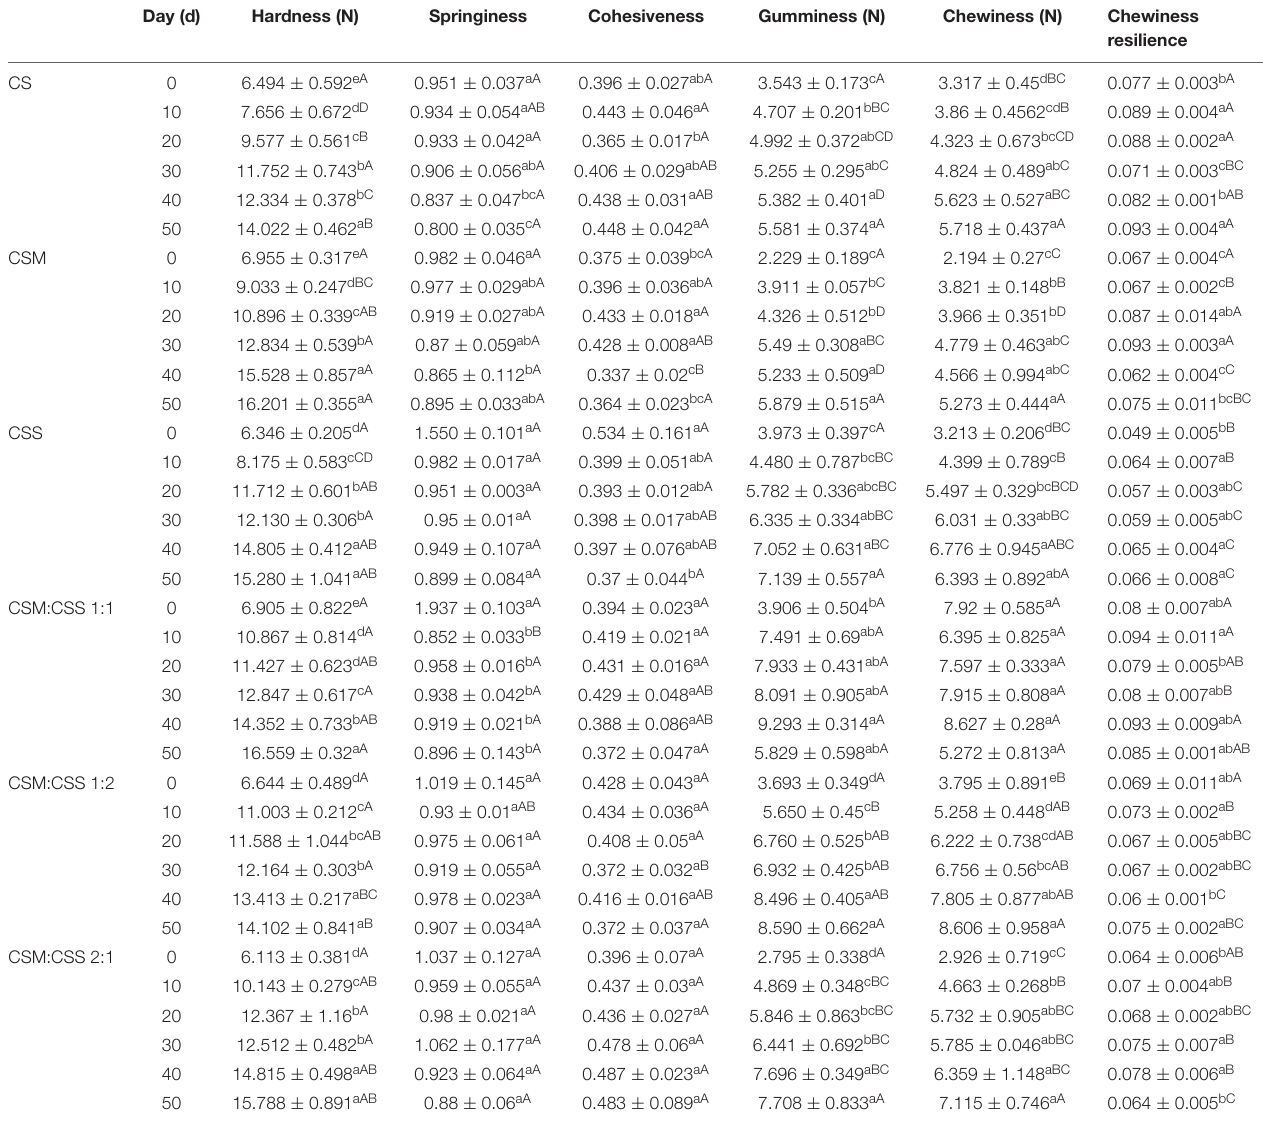
TABLE 1 | Comparative analysis of the textures of the